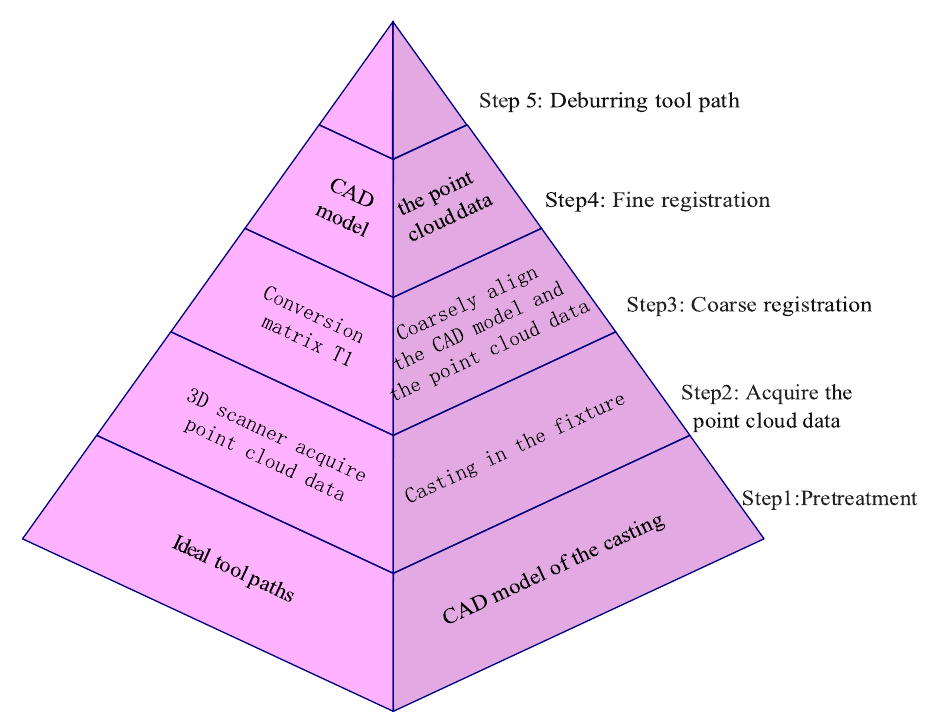
Figure 16. Key steps in grinding path generation.